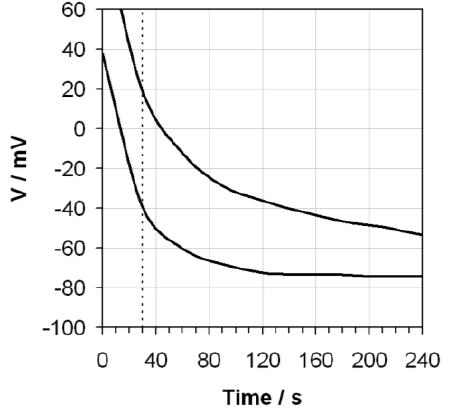
Figure 3. The average maximum and minimum voltages (V) exhibited by three different glass electrodes as a function of time when measuring ethanol containing 0.02 g/g of water using the ASTM D6423 method. The ASTM D6423 specified measurement time is also indicated (vertical dotted line).